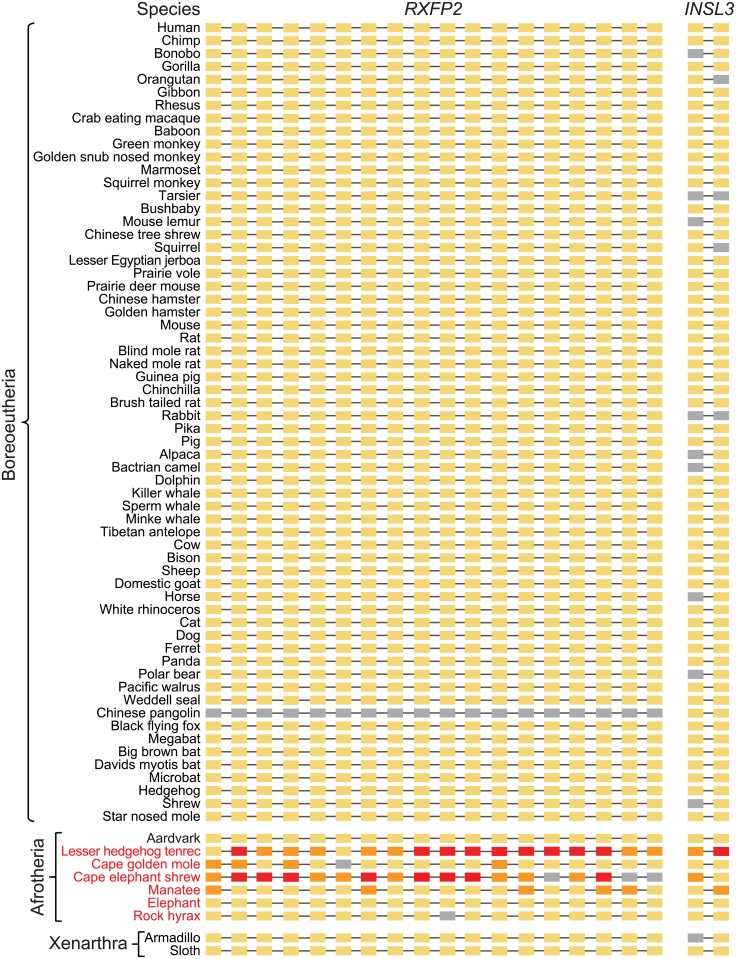
RXFP2 and INSL3 are only lost in several testicond afrotherian lineages.The exon-intron structures of RXFP2 (18 coding exons) and INSL3 (2 coding exons) are shown. A yellow rectangle indicates an intact exon. Exons with inactivating mutations (stop codon or splice site mutations, frameshifts) are indicated in orange; completely deleted or highly diverged exons are indicated in red. Gray exons could not be examined because the respective genome assembly is incomplete at this locus (assembly gap). We could not examine the RXFP2 in the fragmented pangolin genome, because different parts of RXFP2 locus align to at least 5 different short scaffolds. Neither exons nor introns are drawn to scale. INSL3, insulin-like 3; RXFP2, relaxin/insulin-like family peptide receptor 2.